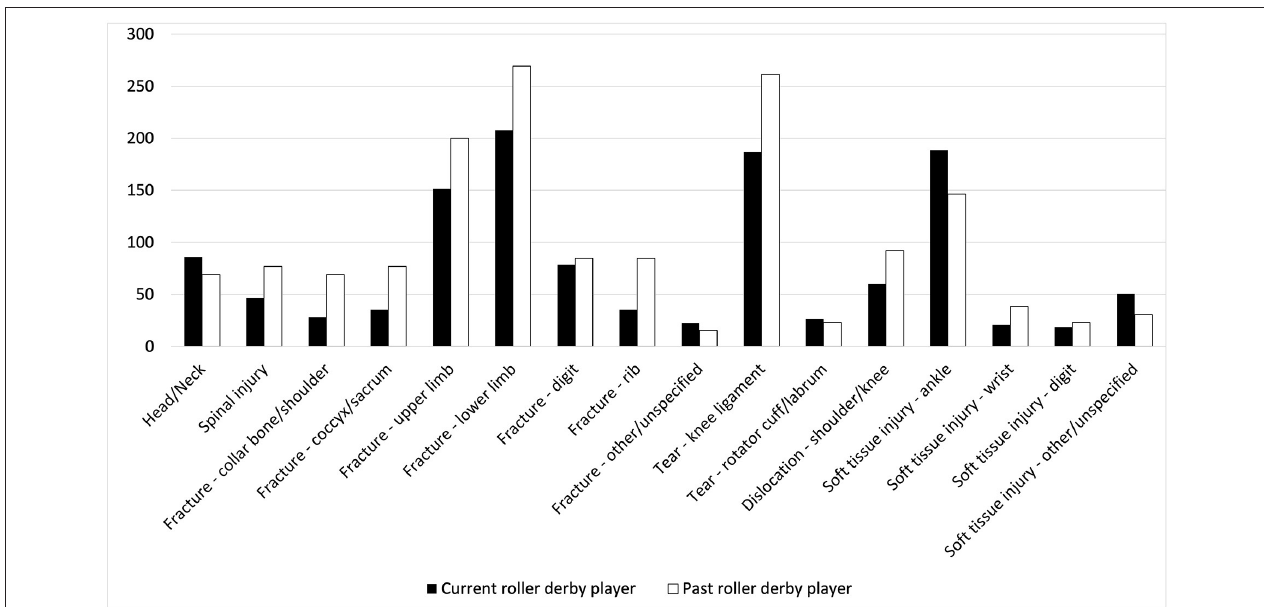
FIGURE 2 | Orthopedic injury history endorsement during roller derby per 1,000 athletes. Head/Neck: whiplash, skull fracture, broken nose; digit: fingers, toes; upper limb: arm, elbow, wrist, hand; lower limb: hip, pelvis, leg, ankle, foot; Soft tissue injury: tears, sprains,